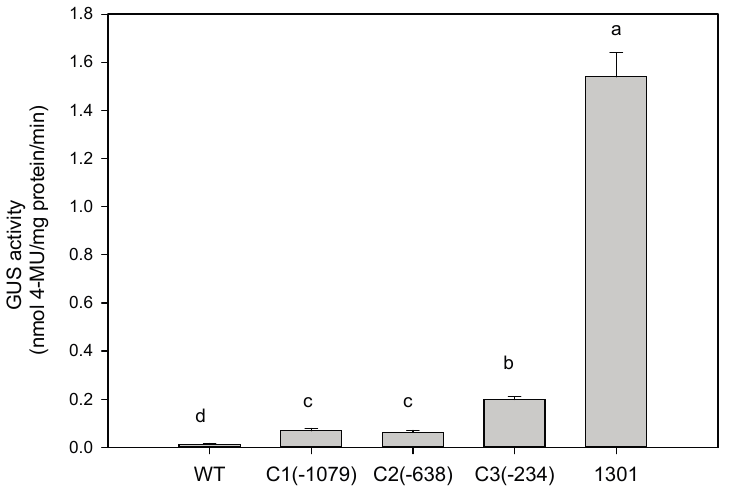
Figure 3. Basal expression analysis of GUS activity in transgenic Arabidopsis lines. GUS activity was analyzed fluorometrically and expressed as nmoles 4-methylumbelliferone (MU)/mg protein/min. Data are expressed as the mean ± standard deviation of three independent assays of Arabidopsis leaf extracts. Six-week-old Arabidopsis T3 plants and wild type (WT) were used for this analysis. Same letters indicate no significant differences at p ≤ 0.05 by Duncan test. C1( − 1,079), C2( − 638), and C3( − 234) represent different deletion promoters. Different letters (a–d) mean statistical differences between